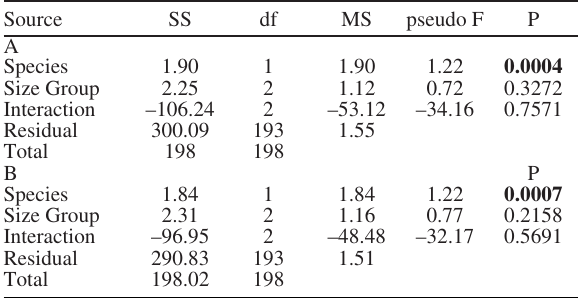
Table 4. – Two-way PERMANOVA results of larval sandperch. A, prey number per gut; B, prey volume per gut. Bold numbers indicate significant (P<0.05) effect.